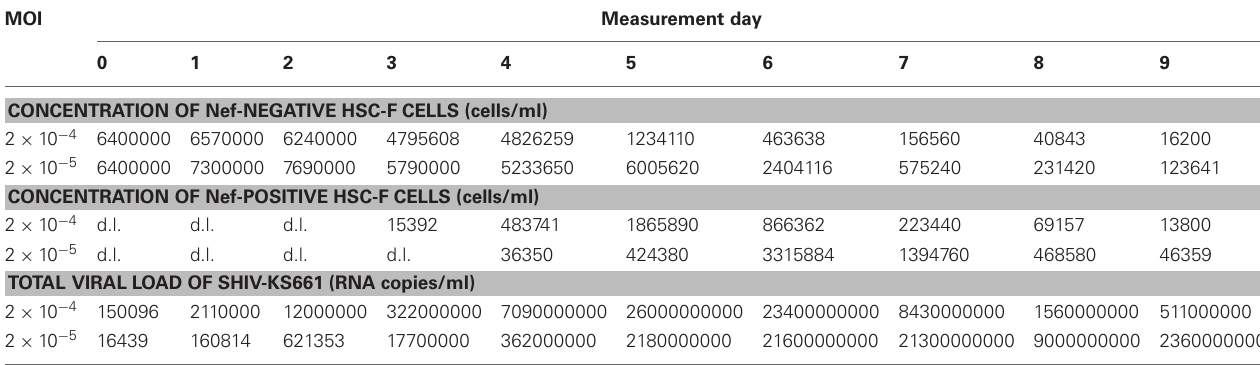
Table 1 | Experimental data for the in vitro experiment. MOI Measurement day